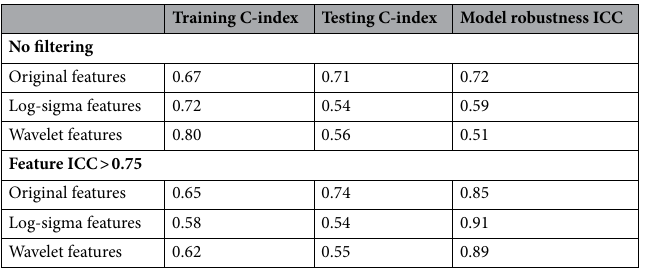
Table 3. The model performance in discrimination and reliability. An improvement in model reliability is observed after removing non-robust radiomic